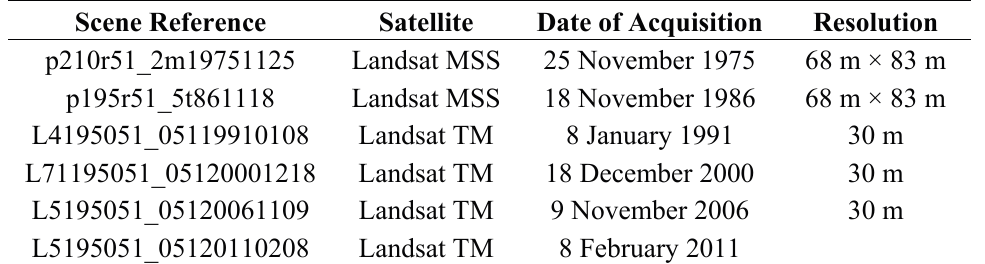
Table 1. References and dates of acquisition of the Landsat data used for this